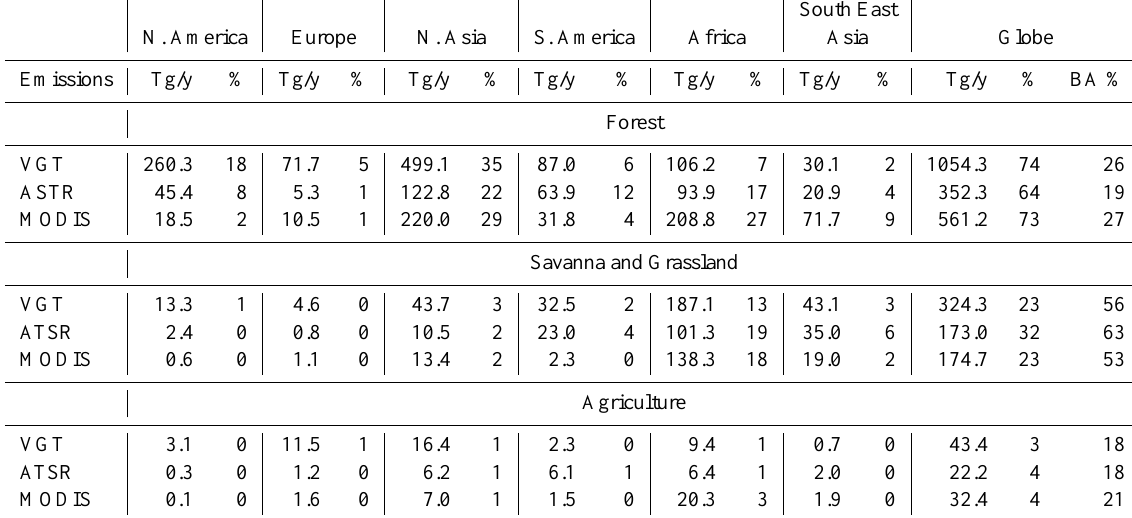
Table 5. Contribution to the total annual CO emissions of forest, savanna/grassland and agriculture over the continental windows and the globe [Tg/y, %]. In the last column, for the globe we also provide percentage of burned area [BA%] in each class.